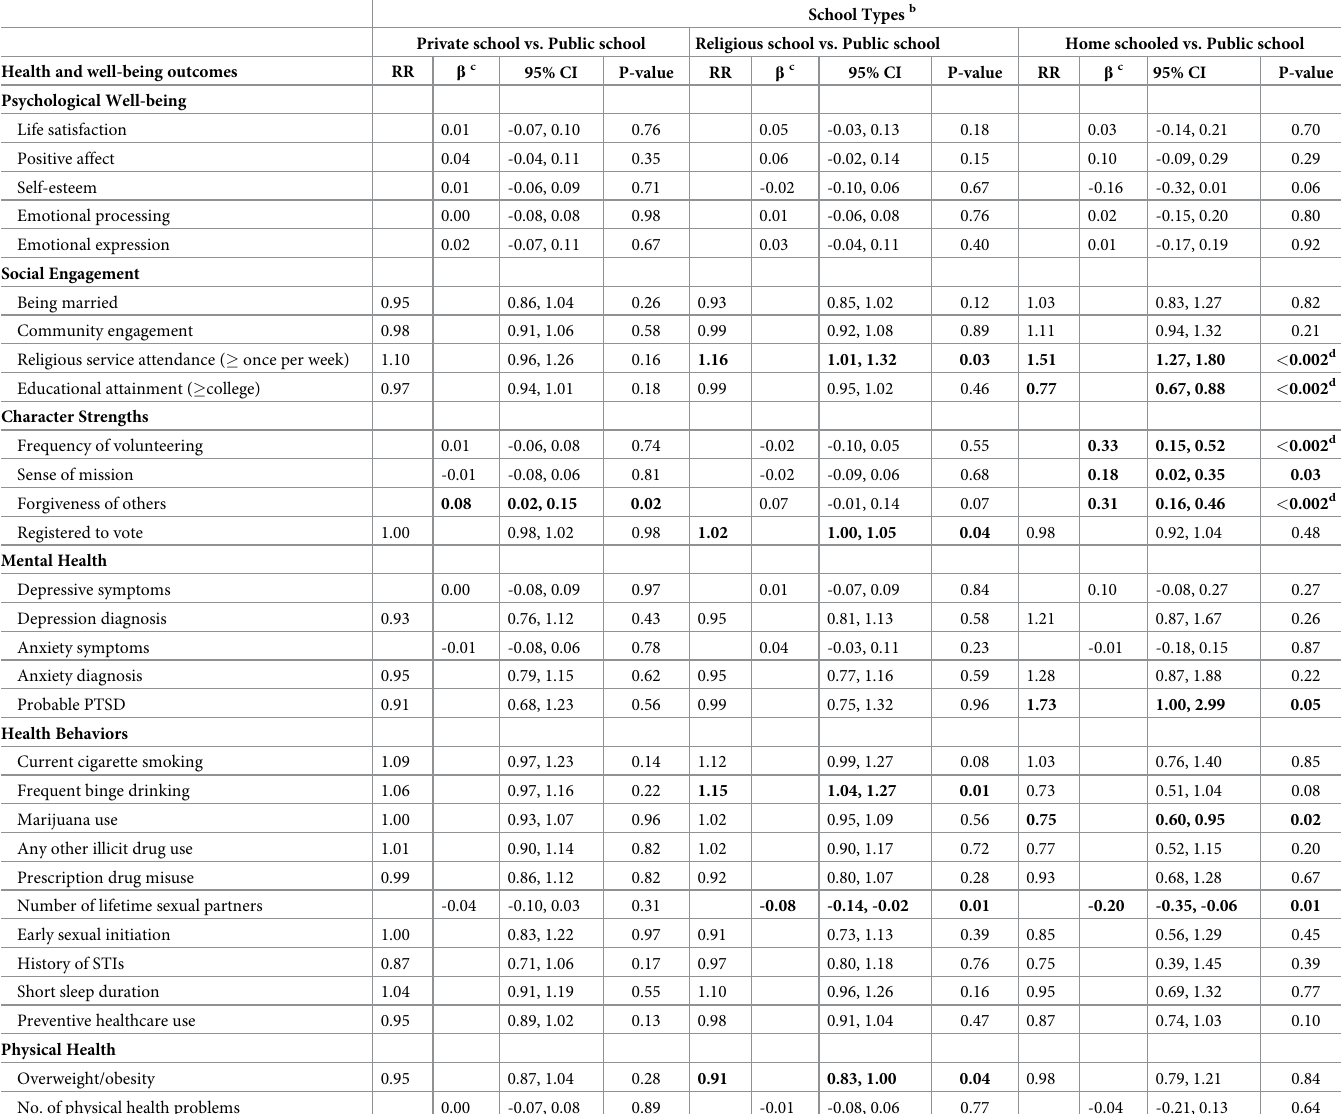
Table 2. School types in adolescence and subsequent health and well-being in young adulthood (Growing Up Today Study from 1999 to 2007, 2010 or 2013 ques- tionnaire wave, N = 12,288 a ).